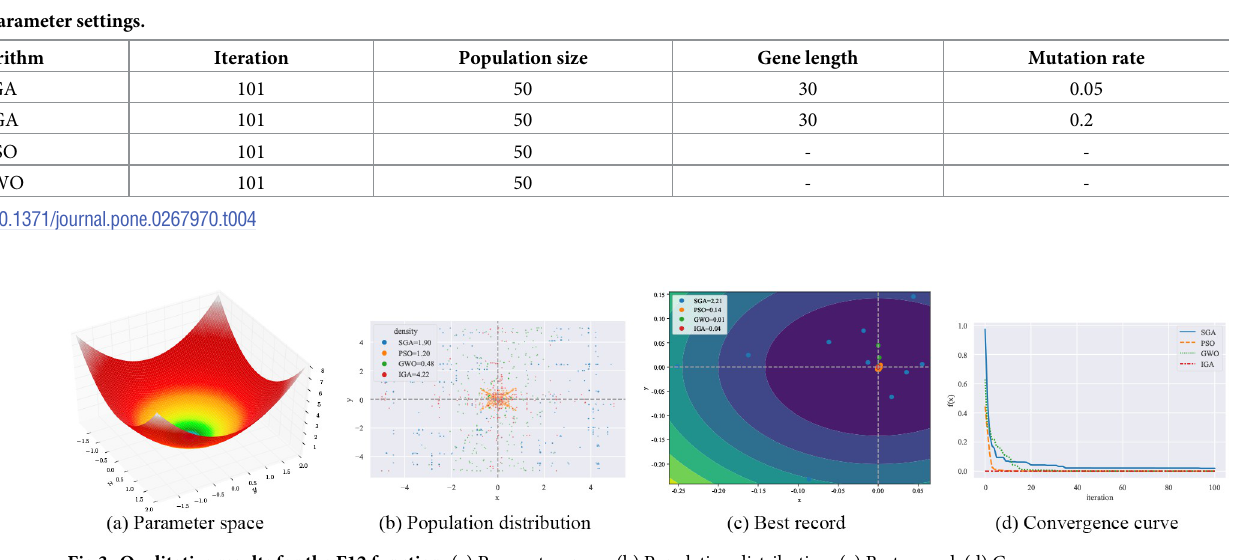
Fig 3. Qualitative results for the F12 function. (a) Parameter space. (b) Population distribution. (c) Best record. (d) Convergence curve.